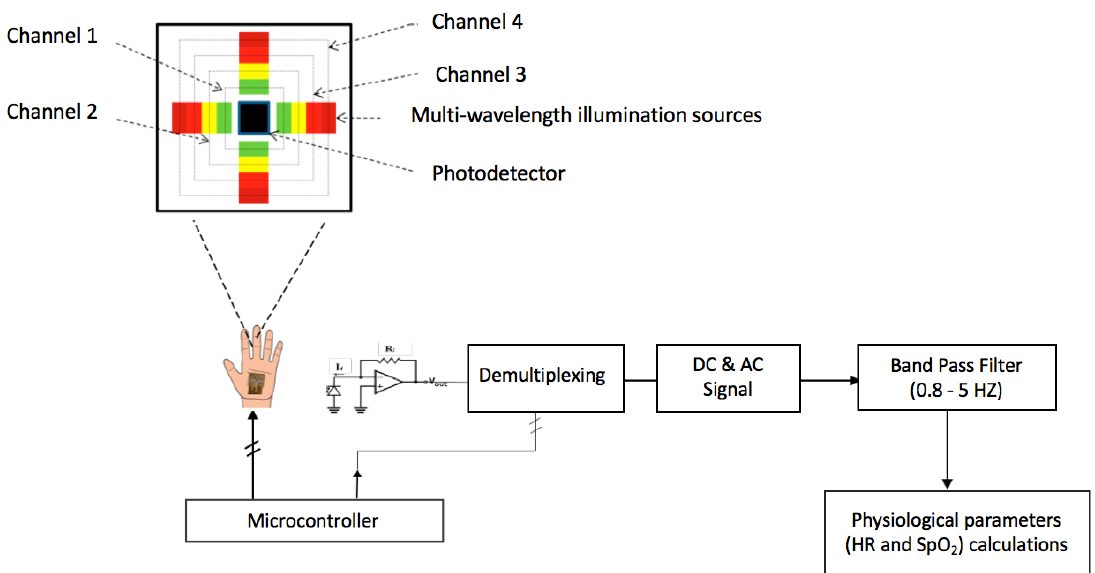
Figure 5. Microcontroller control of the multi-wavelength illumination and de-multiplexing operations. In the mOEPS, the detail of four illumination are: the channel 1: green, the channel 2: orange, the channel 3: red, and the channel 4: near